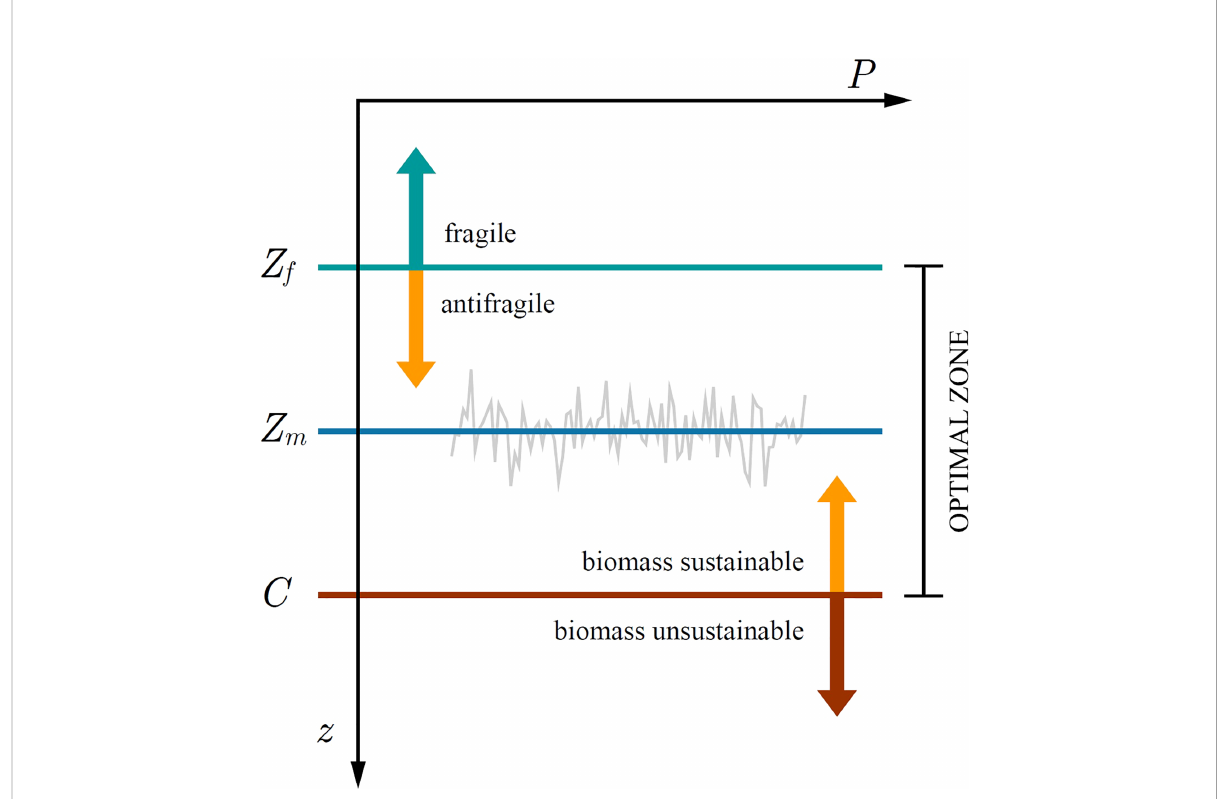
FIGURE 8 Illustration of the optimal zone for phytoplankton growth. At steady state the critical depth S converges onto the mixed layer depth Z m . Below the optically uncoupled critical depth C biomass is unsustainable, whereas above C it is sustainable. Above the fragility depth Z f phytoplankton biomass is suppressed from mixed-layer variability, whereas below Z f it is increased. In the depth range from Z f up to C phytoplankton can both be sustained and is antifragile to variability in mixed-layer